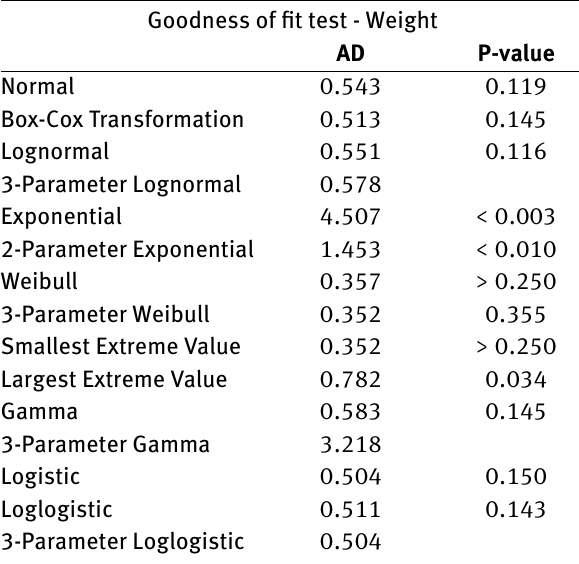
Table 8: Individual distribution identification for the ABS maximum stress σ max .